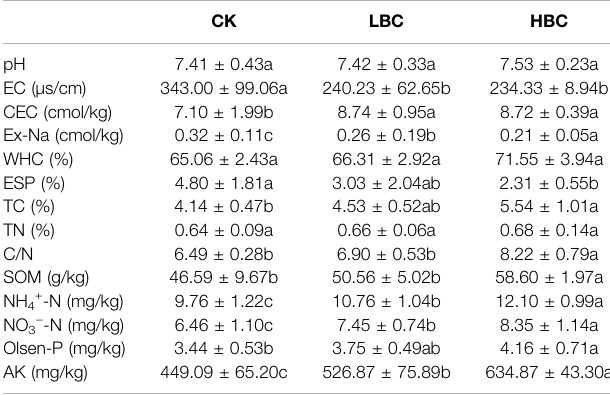
TABLE 1 | Effects of biochar on soil physicochemical properties and nutrient